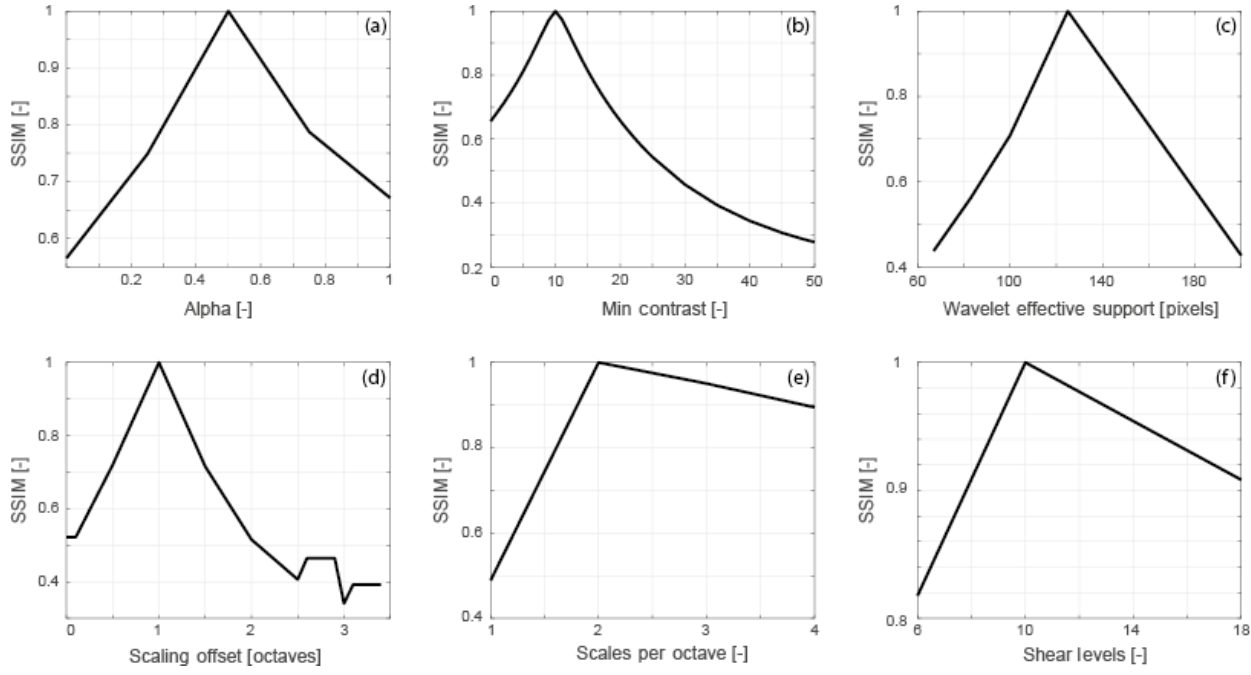
Figure A3. Variation in the structural similarity index of base case ridges with shearlet and detection parameters. (a) SSIM vs. anisotropy exponent. (b) SSIM vs. minContrast . (c) SSIM vs. wavelet effective support. (d) SSIM vs. scaling offset. (e) SSIM vs. scales or octave. (f) SSIM vs. shear